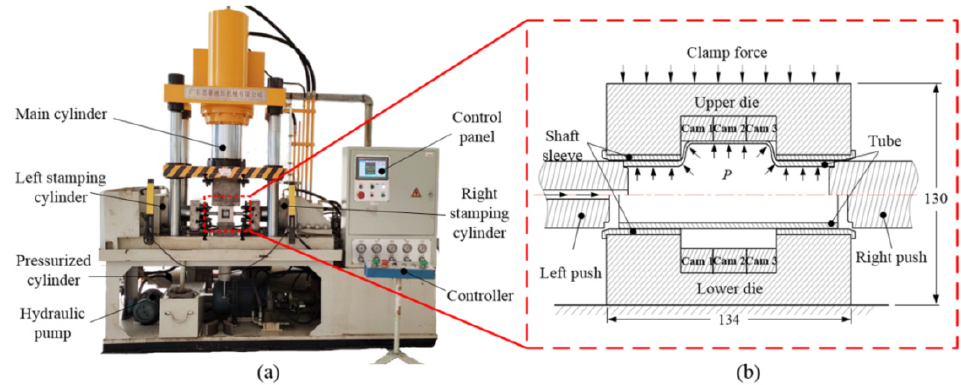
Figure 2. ( a ) CNC tube hydroforming system YB98-200A and ( b ) the connection principle of the assembled camshaft [29].